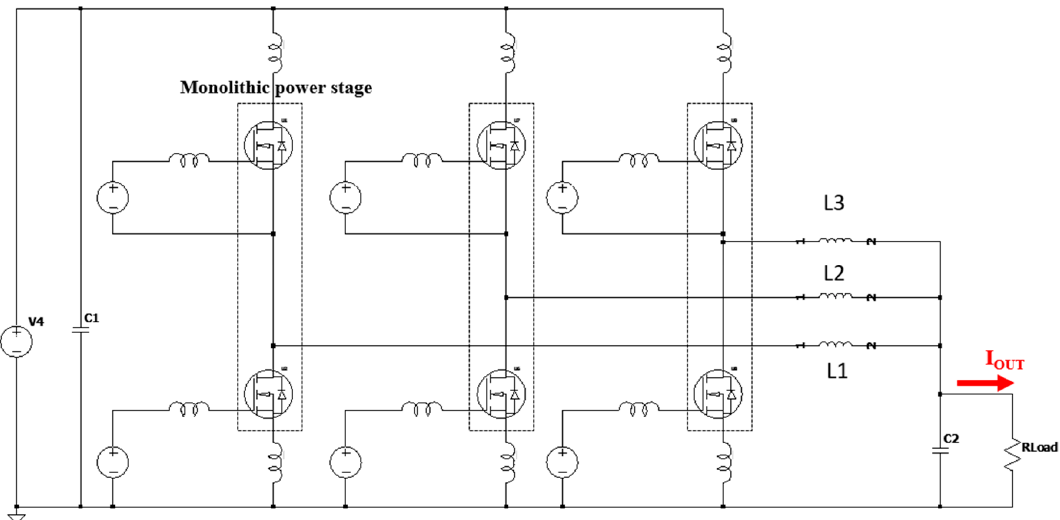
Figure 8. Schematic of a three-phase synchronous buck converter.